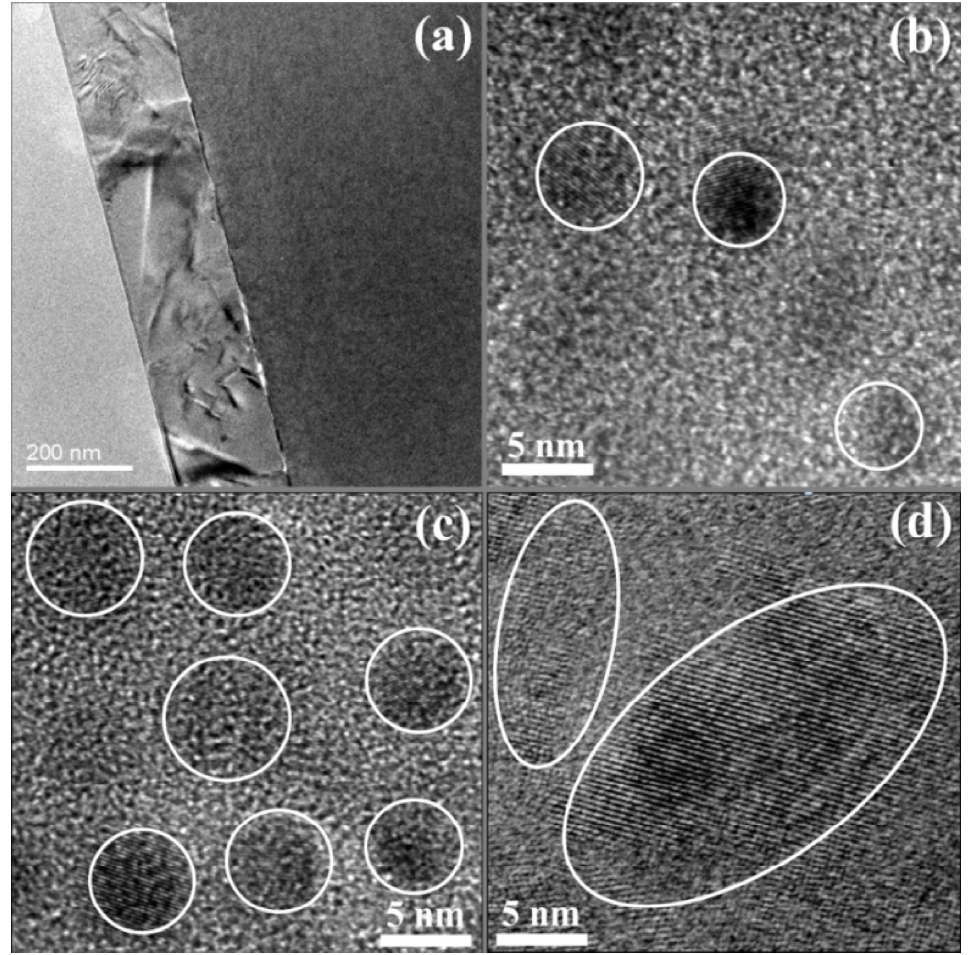
Figure 2. Transmission electron microscopy (TEM) images of B-doped Si NCs: a -SiC films with various Si/C ratios, including ( a ) cross-sectional TEM image of annealed sample; and ( b ) R = 1; and ( c ) R = 2; and ( d ) R =